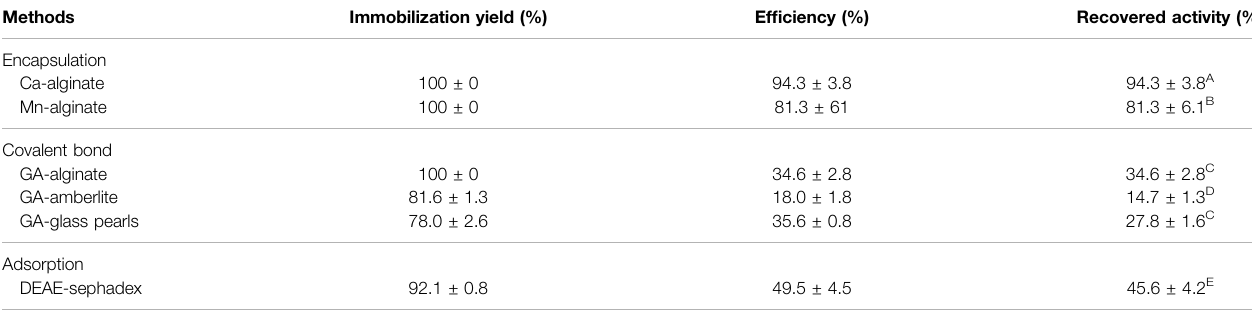
TABLE 2 | Immobilization of A. fumigatus CAS21 tannase using different methods and supports. Methods